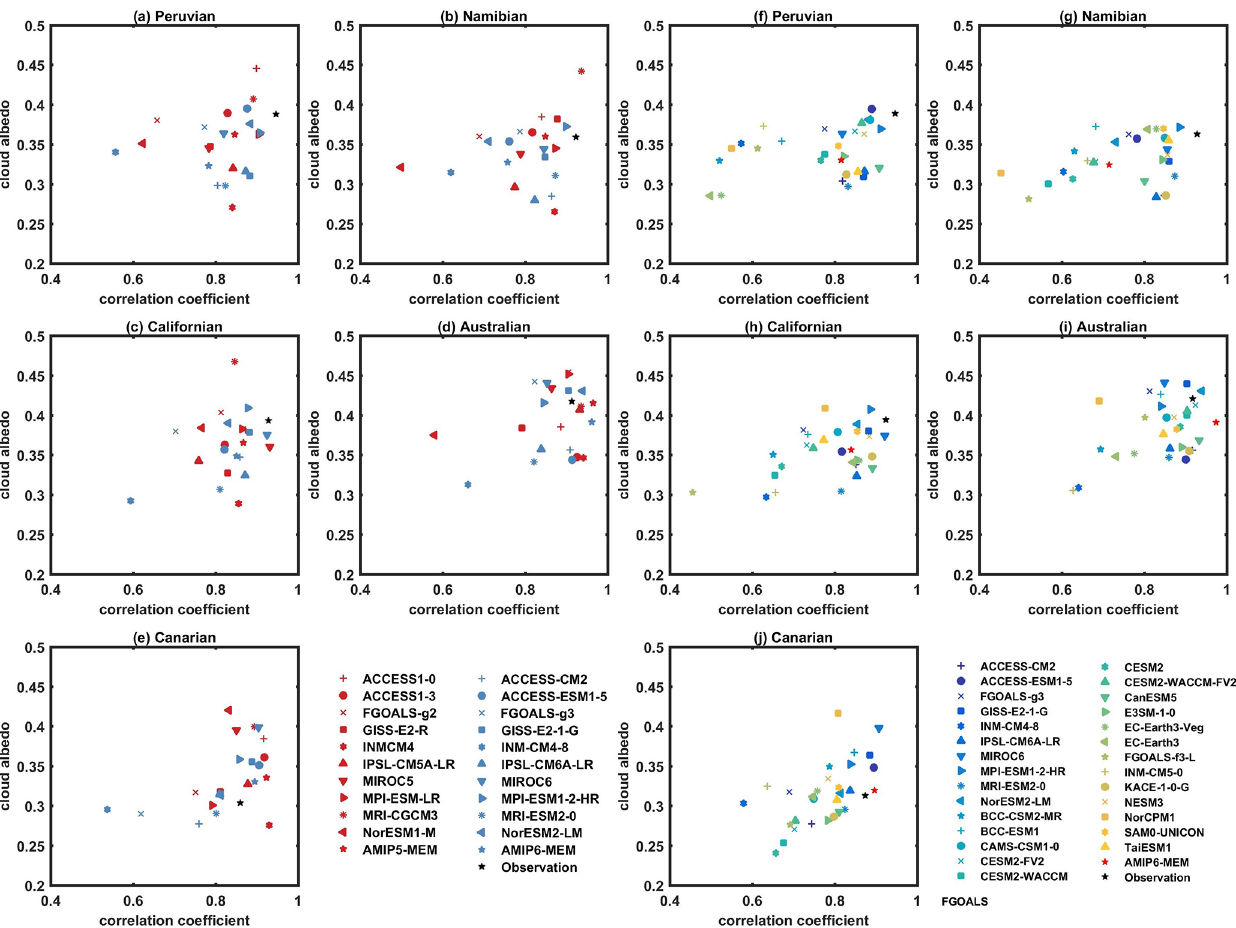
Figure 2. The estimated long-term mean cloud albedo and corresponding correlation coefficient from the relation between planetary albedo and cloud fraction (a–e) from satellite observations (black symbol), 11 AMIP5 (red symbols) models and 11 AMIP6 (blue symbols) models during 2003–2008 and (f–j) from satellite observations and 29 AMIP6 models during 2003–2014 over the (a, f) Peruvian, (b, g) Namibian (c, h) Californian, (d, i) Australian and (e, j) Canarian